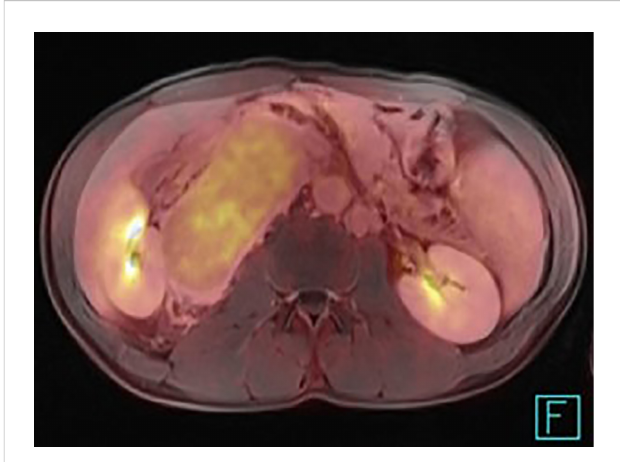
FIGURE 8 PET/MRI of the unicentric form of Castleman disease presenting a relatively low uptake of 18F- fl uorodeoxyglucose.